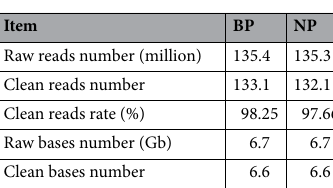
Table 1. A. sinensis NGS data. BP Bolting plants, NP normal plants. a Reads with a quality score < 30 and length < 60 bp were excluded.